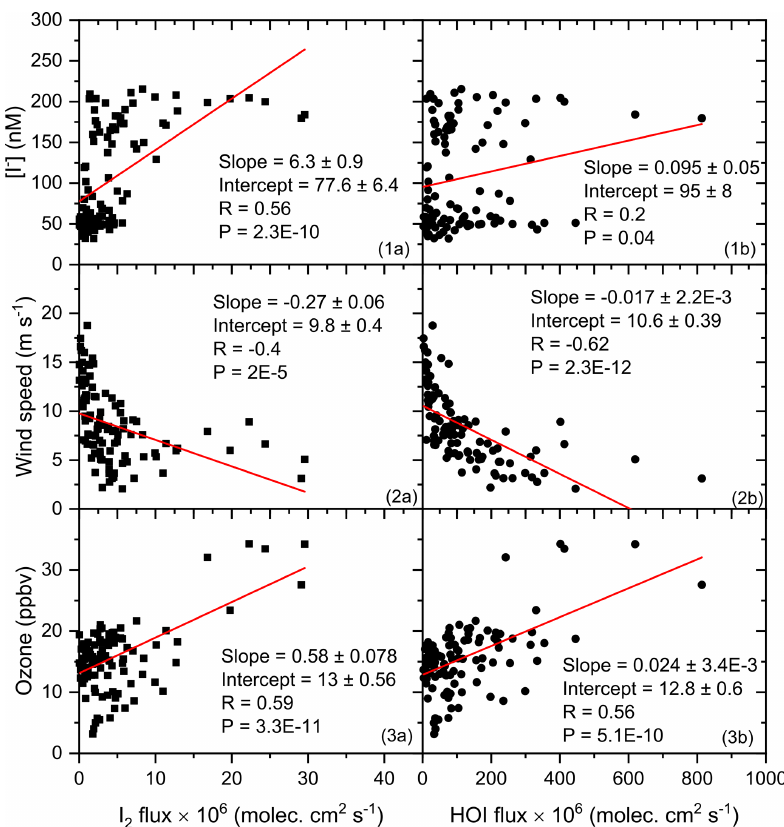
Figure 7. Linear fit of daily average sea surface iodide (SSI) concentration, wind speed, and ozone mixing ratio ( y axis) against the calculated I 2 and HOI flux ( x axis) for the entire campaign. HOI and I 2 are calculated with SSI estimated using the modified Chance parameterisation for the Indian Ocean and Southern Ocean in Eq.